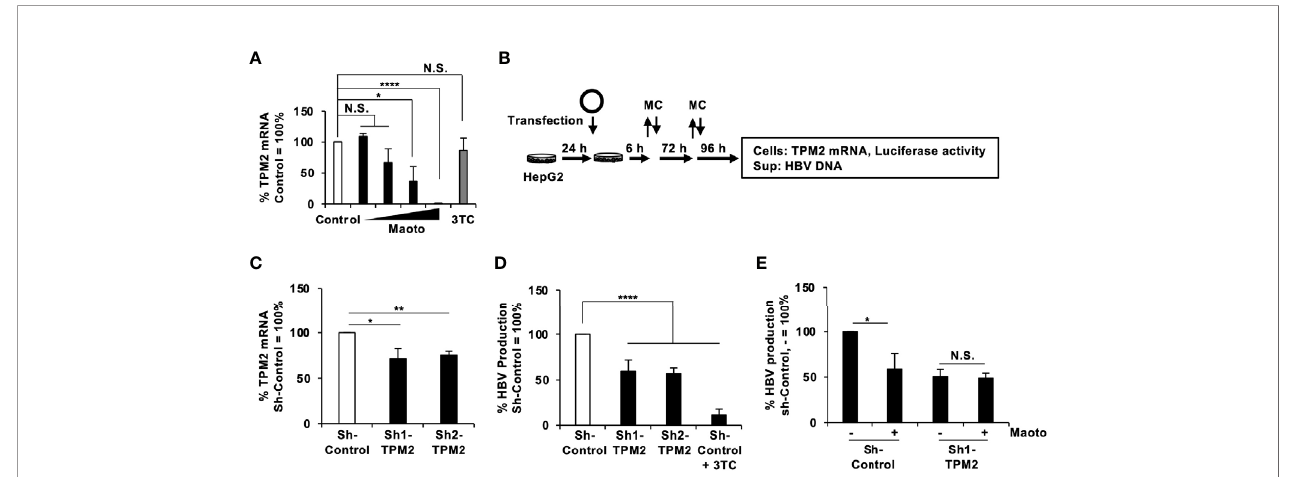
FIGURE 5 | Tropomyosin b chain (TPM2) knockdown decreases hepatitis B virus (HBV) production. (A) TPM2 mRNA in maoto-treated cells. HepG2-NTCP cells were treated with distilled water (control) or concentrations of 1.5625, 6.25, 25, and 100 µg/ml of maoto extract for 9 days. The amount of TPM2 mRNA was measured by real-time RT-PCR. (B) Schematic representation of the protocol of maoto treatment and transfection of an HBV-expressing plasmid together with an sh-TPM2-expressing plasmid in HepG2 cells. The remaining plasmids were washed at 6 h after the transfection and the medium was refreshed (MC). The medium was further refreshed at 3 days after the transfection (MC). (C) TPM2 mRNA in sh-TPM2-expressing cells. Knockdown of TPM2 was con fi rmed at 7 days after the transfection by real-time RT-PCR. (D) Effect of TPM2 knockdown on HBV production. HBV DNA in culture supernatants of the cells was measured by real-time PCR and normalized with the transfection ef fi ciency based on luciferase activity of the cells. Lamivudine (1 µM, 3TC) was used as a positive control for the inhibition of HBV production. (E) Effect of maoto extract on HBV production in sh-TPM2-expressing cells. Values are expressed as the mean percentage + S.E. of three independent experiments. * P < 0.05; ** P < 0.01; **** P < 0.001; N.S., no signi fi